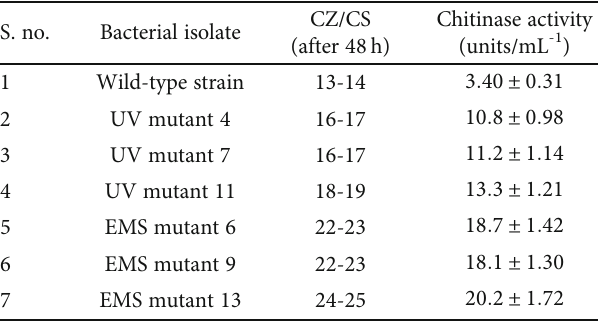
Figure 3: Survival curve of mutagenesis. (a) UV survival curve of Bacillus licheniformis SSCL-10. (b) EMS survival curve of Bacillus licheniformis SSCL-10 UV-11. Table 1: Ratio of zone of clearance (CZ)/size of colony (CS) and chitinase activity of Bacillus licheniformis SSCL-10 wild type, maximum CZ/CS of three mutants of UV and EMS strains were selected for chitinase production.